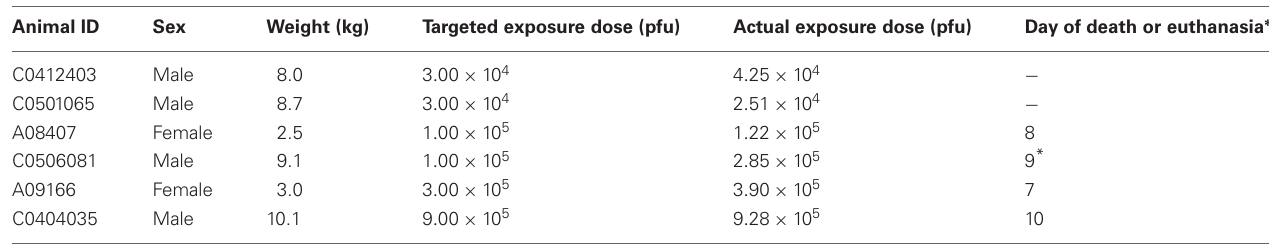
Table 1 | Exposure dose